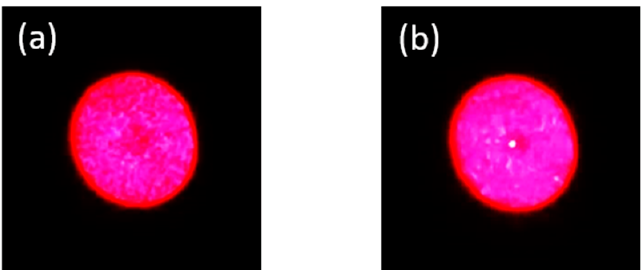
Figure 3. The PC mPOF end-face images through an objective illuminated by the red light. ( a ) Misalignment image with a uniform end-face. ( b ) The POF and the SOF are well aligned with a brighter point in the center of the fiber end-face image.